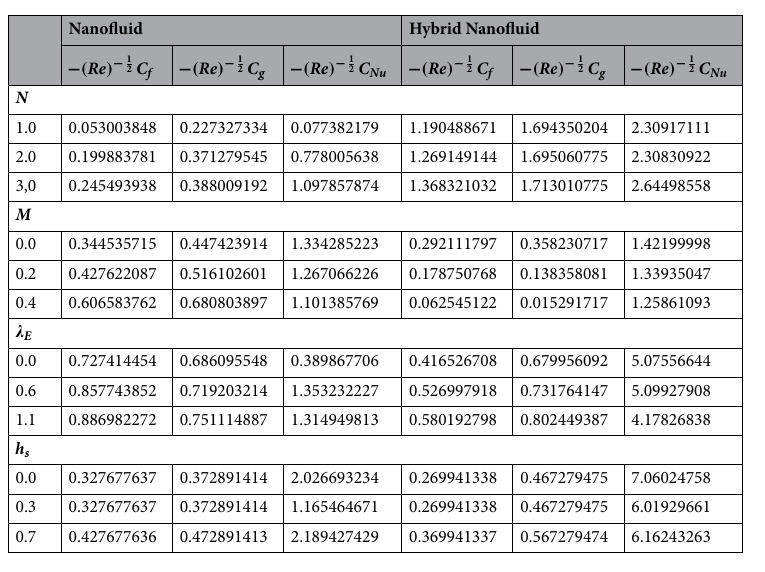
Table 2. Statistical outcomes for physical quantities, such as skin